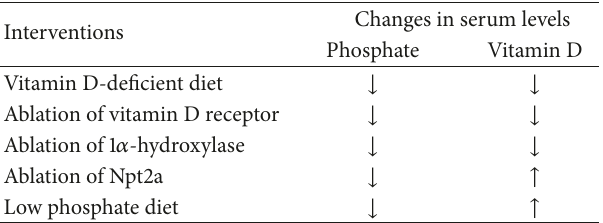
Table 1: Interventions that alleviate the aging-like phenotypes in Klotho-deficient mice and/or FGF23-deficient mice and associated changes in serum levels of phosphate and 1,25-dihydroxyvitamin D 3 (Vitamin